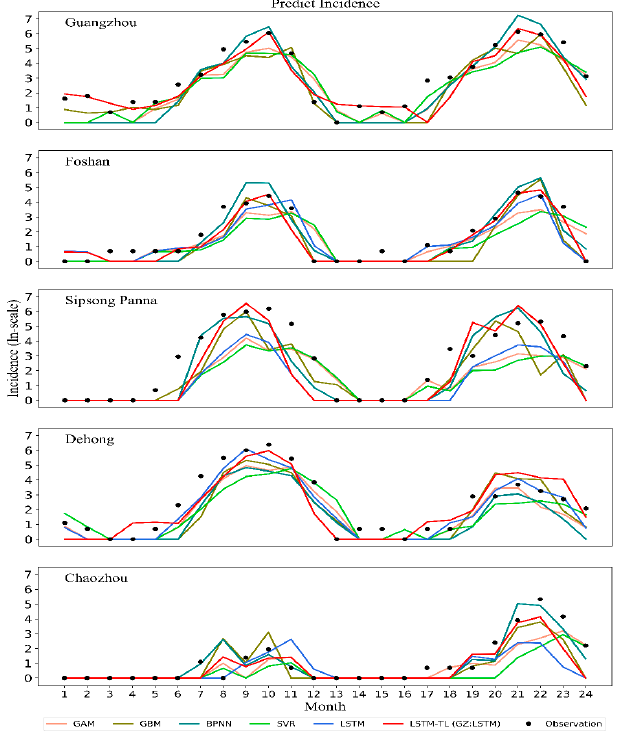
§ and bold indicate the values of the RRSE of this model were the smallest.